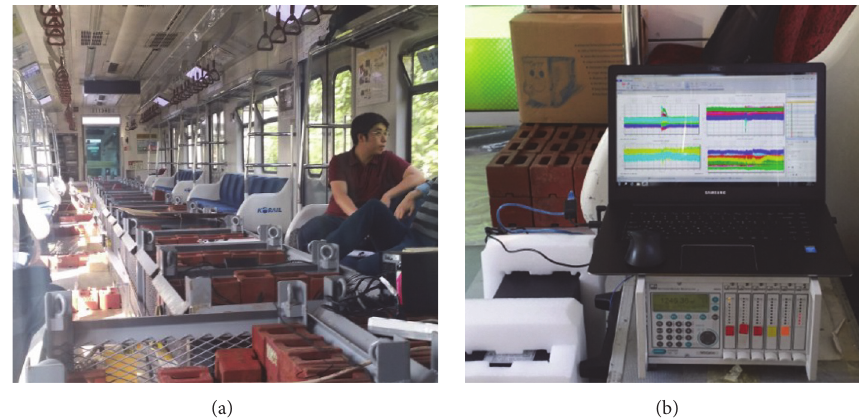
Figure 10: Test vehicle and data acquisition system for track test.